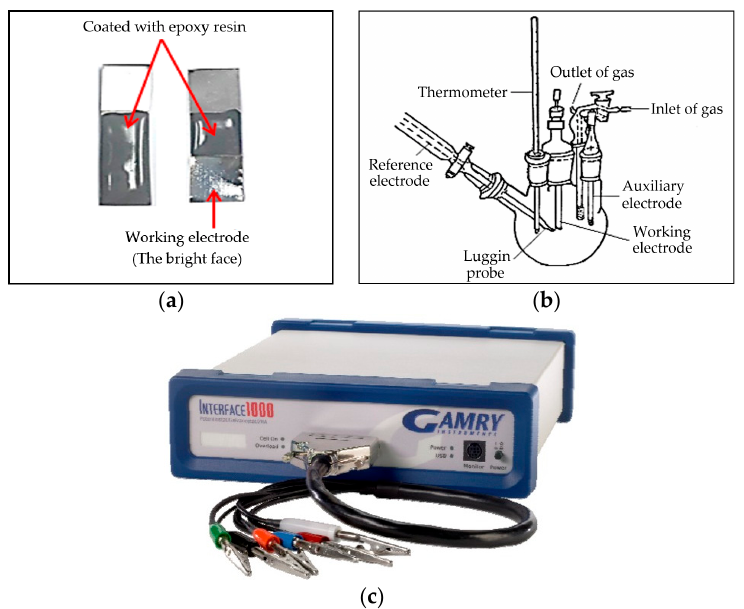
Figure 1. ( a ) Ni-base glassy alloy; ( b ) schematic diagram for the electrochemical cell; ( c ) the Gamry interface 1000 TM .